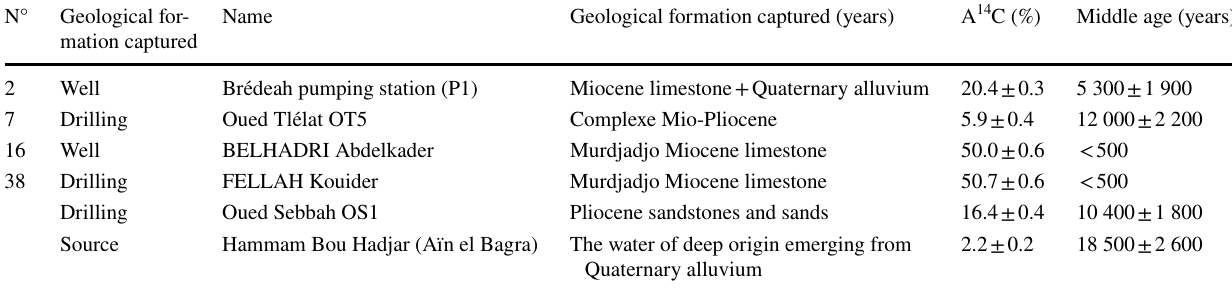
Table 5 Average radiometric age of the waters of the aquifer system of the Great Sebkha of Oran